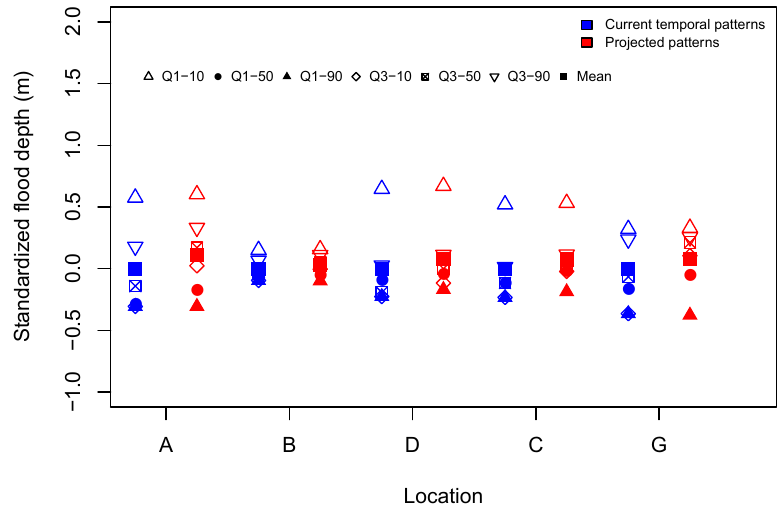
Figure 8. Impact of rise in temperature on the peak flood depth variation at reference locations within the watershed when scaling is applied only to temporal patterns. The peak flood depths at each reference point are based on 160mm of total rain distributed over the six temporal patterns used. Temperature scaling ( T/S ) for the temporal patterns is based on scaling fractions presented in Fig. 3. Flood depths were standardized by subtracting the mean from the base simulations presented in Fig. 6 for each location. The mean flood depth is shown as solid squares.